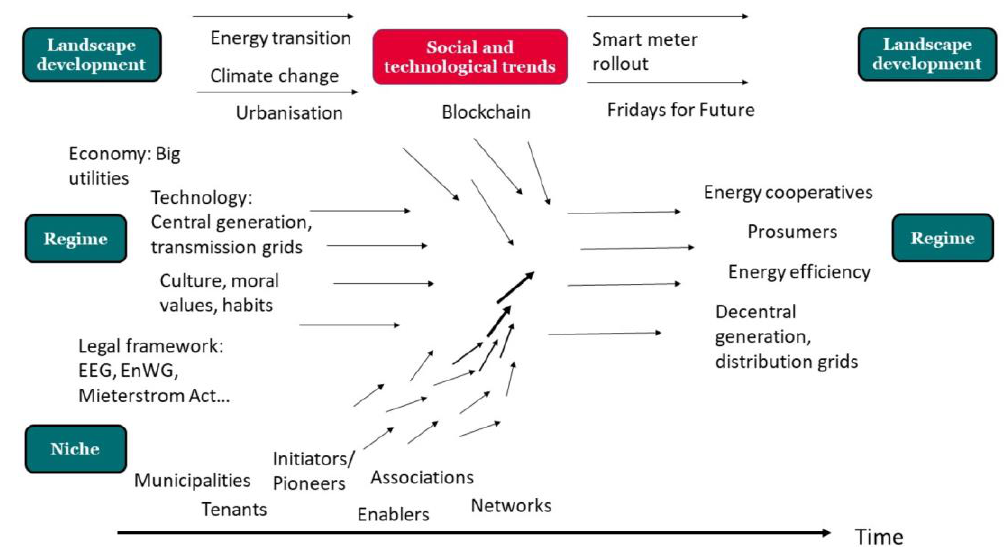
Figure 1. Transition of the energy system with tenant electricity; the length of the arrows refers to the time, the width to the intensity of the influence exerted; Source: Own illustration, based on [50].